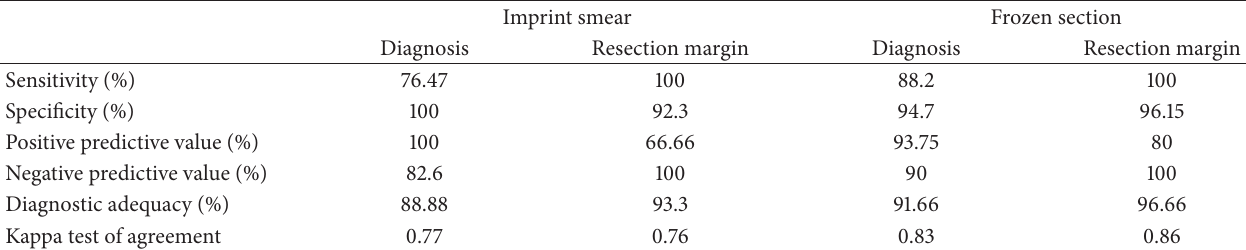
Table 2: Statistical analyses of results given by imprint smear and frozen section